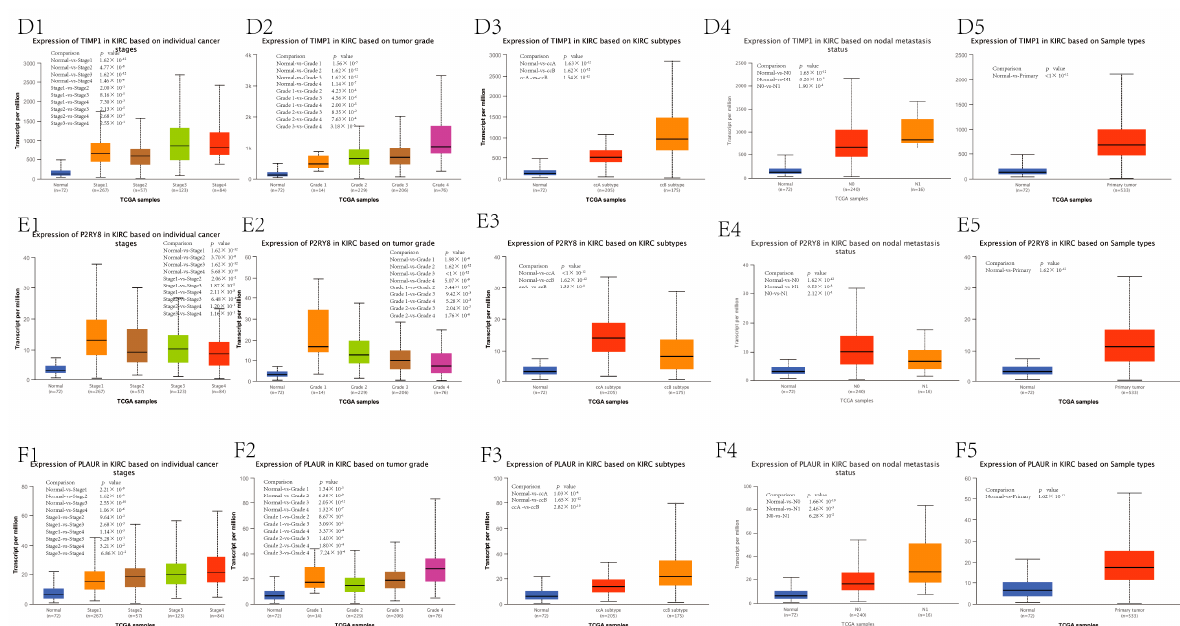
Figure 7. The correlation between the expression of hub genes and clinicopathological features. ( A1 – A5 ) Box diagrams visualize the expression of CASR in different clinical stages ( A1 ), pathological grades ( A2 ), subtypes ( A3 ), numbers of metastatic lymph nodes ( A4 ), and tissues ( A5 ). ( B1 – B5 ) Box diagrams visualize the expression of CAT in different clinical stages ( B1 ), pathological grades ( B2 ), subtypes ( B3 ), numbers of metastatic lymph nodes ( B4 ), and tissues ( B5 ). ( C1 – C5 ) Box diagrams visualize the expression of ERBB2 in different clinical stages ( C1 ), pathological grades ( C2 ), subtypes ( C3 ), numbers of metastatic lymph nodes ( C4 ), and tissues ( C5 ). ( D1 – D5 ) Box diagrams visualize the expression of TIMP1 in different clinical stages ( D1 ), pathological grades ( D2 ), subtypes ( D3 ), numbers of metastatic lymph nodes ( D4 ), and tissues ( D5 ). ( E1 – E5 ) Box diagrams visualize the expression of P2RY8 in different clinical stages ( E1 ), pathological grades ( E2 ), subtypes ( E3 ), numbers of metastatic lymph nodes ( E4 ), and tissues ( E5 ). ( F1 – F5 ) Box diagrams visualize the expression of PLAUR in different clinical stages ( F1 ), pathological grades ( F2 ), subtypes ( F3 ), numbers of metastatic lymph nodes ( F4 ), and tissues ( F5 ). p < 0.05 indicates that the difference is statistically